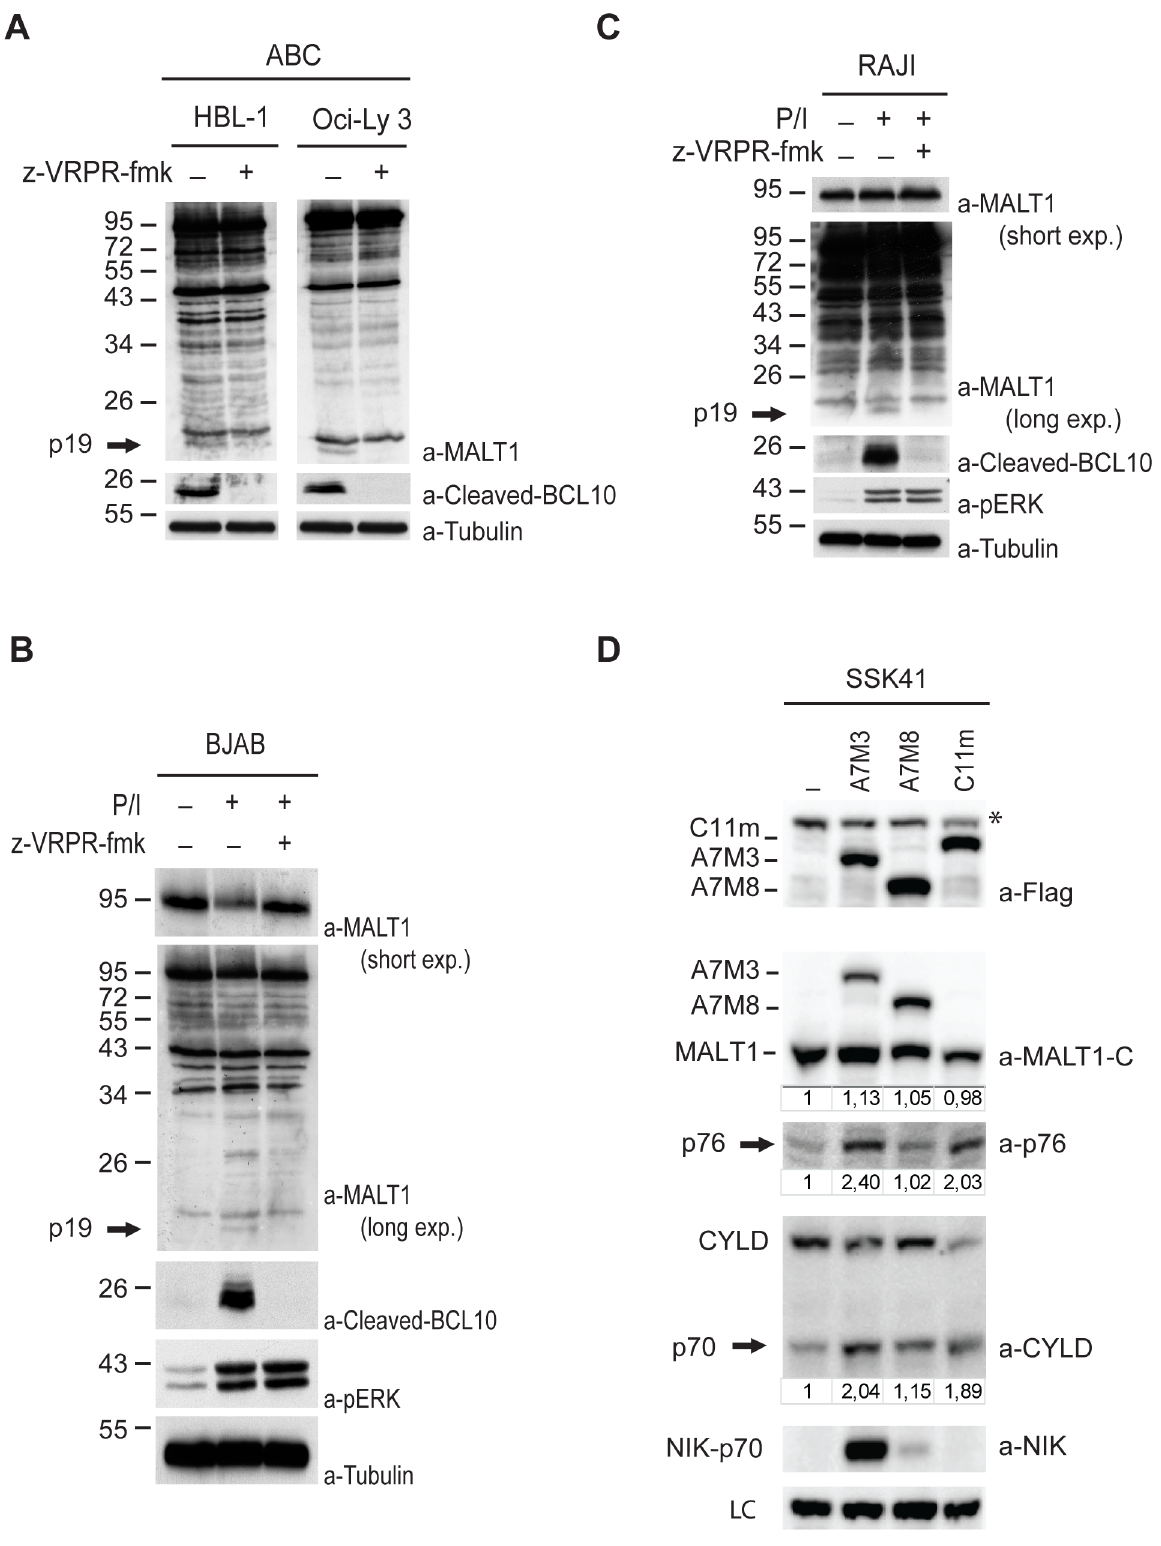
Figure 5. MALT1 auto-proteolysis in activated B cells. A) ABC-DLBCL cell lines HBL-1 and OCI-Ly3 were treated with 50 m M z-VRPR-fmk (36 hrs) and lysates were analysed for the presence of MALT1 and BCL10 cleavage fragments with a-MALT1, a-Cleaved BCL10 and a-Tubulin (loading control). B-C) The GCB-DLBCL cell lines BJAB and Raji were left untreated or stimulated with PMA/ionomycin (30 min) with or without pre-treatment with 50 m M z-VRPR-fmk (30 min). Lysates were analysed for the presence of MALT1 and BCL10 cleavage fragments, for p-ERK (activation control) and tubulin (loading control). D) Immunoblot of lysates of SSK41 cells and SSK41 cells with ectopic expression of the API2-MALT1 fusion variants A7M3